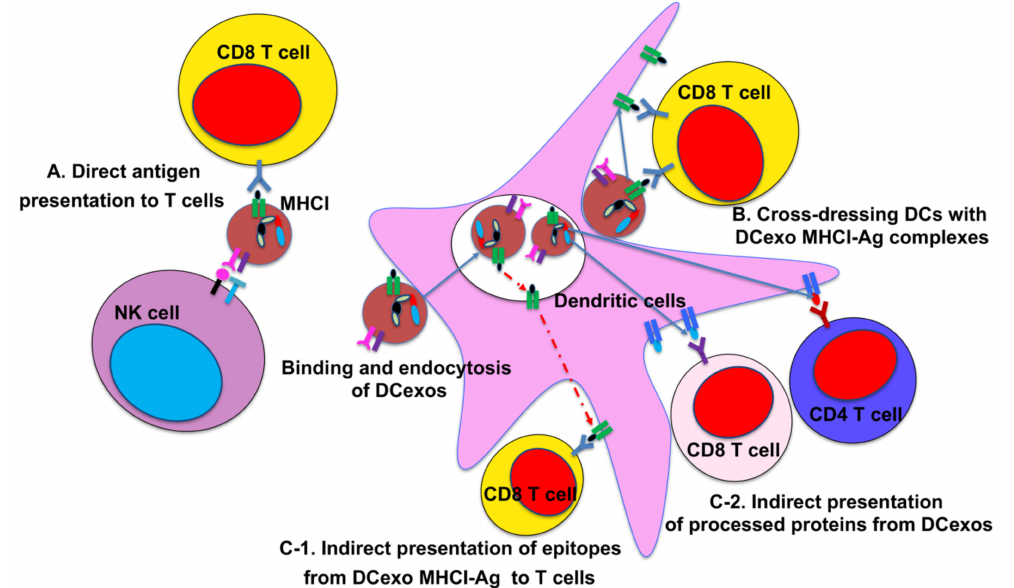
Figure 2. DCexo-mediated antigen presentation to activate T cells. ( A ): The presence of MHC Exo -Ag complexes on the surface of DCexos enables them to activate antigen-specific CD4 and CD8 T cells directly. Only MHCI and CD8 T cells are illustrated. NK cell-expressed ligands (NKG2D-L, IL-15R and BAG6) on DCexos can also activate natural killer (NK) cells directly. ( B – C ): DCexos activate antigen-specific T cells more efficiently indirectly via bystander DCs. ( B ): DCexos can transfer MHC Exo -Ag complexes to the DC plasma membrane, a process termed cross-dressing, leading to activation of antigen-specific T cells. MHC of DCexos and T cells has to be the same while MHC of the bystander DCs is not required. DCexos can also transfer MHC Exo -Ag complexes to tumor cells to be presented to host T cells (not depicted). ( C ): After internalization, ( C-1 ) DCexos could transfer antigenic peptides to the MHC DC in bystander DCs. The pMHC DC complexes could be transported to the DC plasma membrane to be presented to T cells. DCexos, bystander DCs and T cells are required to have the same MHC in this mode. ( C-2 ) Protein antigens carried by DCexos could be processed by bystander DCs, and multiple and different epitopes for both CD4 and CD8 T cells could be presented on MHC of bystander DCs. Only bystander DCs and T cells need to have the same MHC, allowing DCexos to induce allogeneic T cell responses.